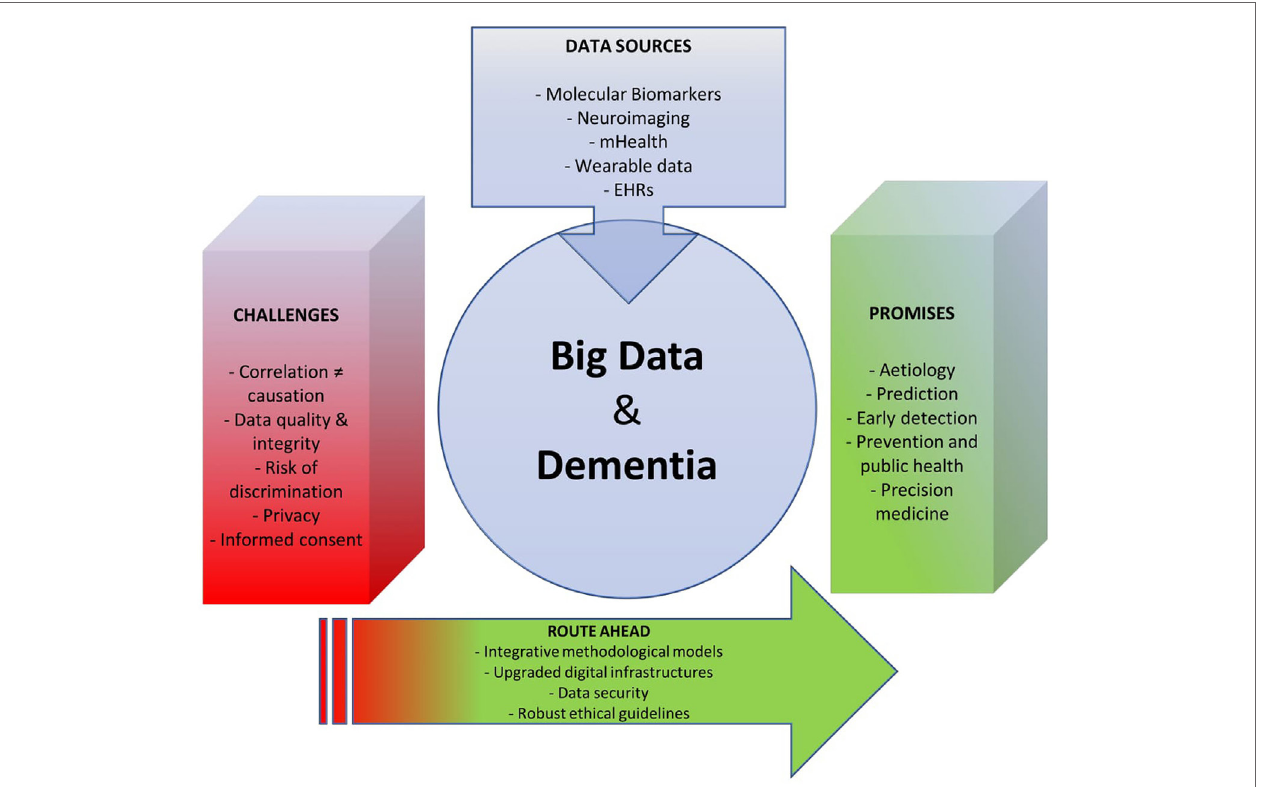
FiGUre 1 | Tackling the global dementia epidemic requires the deployment of all possible scientific and health policy means. Yet, success in this ongoing battle also depends, and in a crucial way, on targeting the right enemy and using available resources efficiently. As the big data turn starts to invest medicine, opportunities emerge to deploy new, effective weapons against this disabling condition. Our analysis revealed that the prospect of using big data for dementia research and care is still in its infancy, and that numerous challenges lie ahead on the way to furthering progress in this field. An integrative approach can overcome such obstacles and help reap the benefits of big data in dementia research and